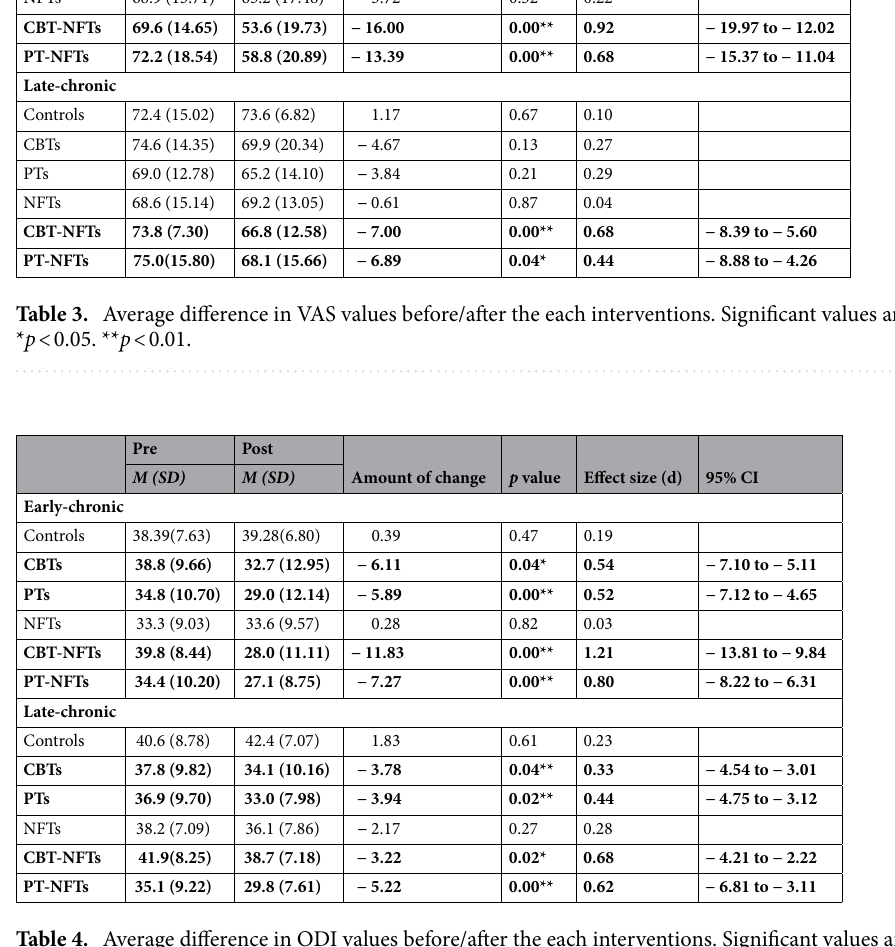
Table 4. Average difference in ODI values before/after the each interventions. Significant values are in [bold]. * p < 0.05. ** p <